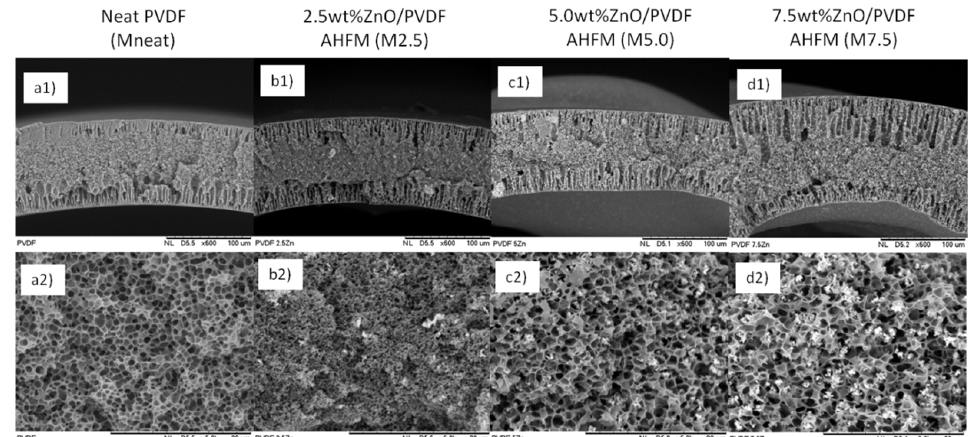
Figure 1. Cross-sectional images of ( a1 , a2 ) neat PVDF(MNeat) ( b1 , b2 ) 2.5 wt.% ZnO/PVDF (M2.5) ( c1 , c2 ) 5.0 wt.% ZnO/PVDF (M5.0) and ( d1 , d2 ) 7.5 wt.% ZnO/PVDF (M7.5) AHFM at different mag- nification.